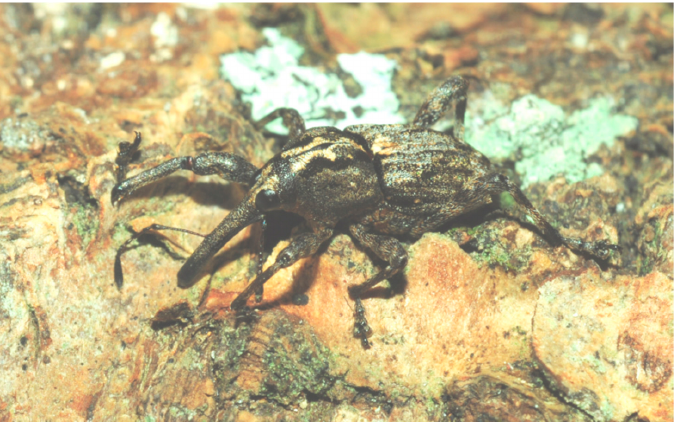
Figure 5. Ilacuris laticollis reared from Araucaria logs collected at Murwillumbah, Queensland, Australia (image used with permission from Geoff Williams).